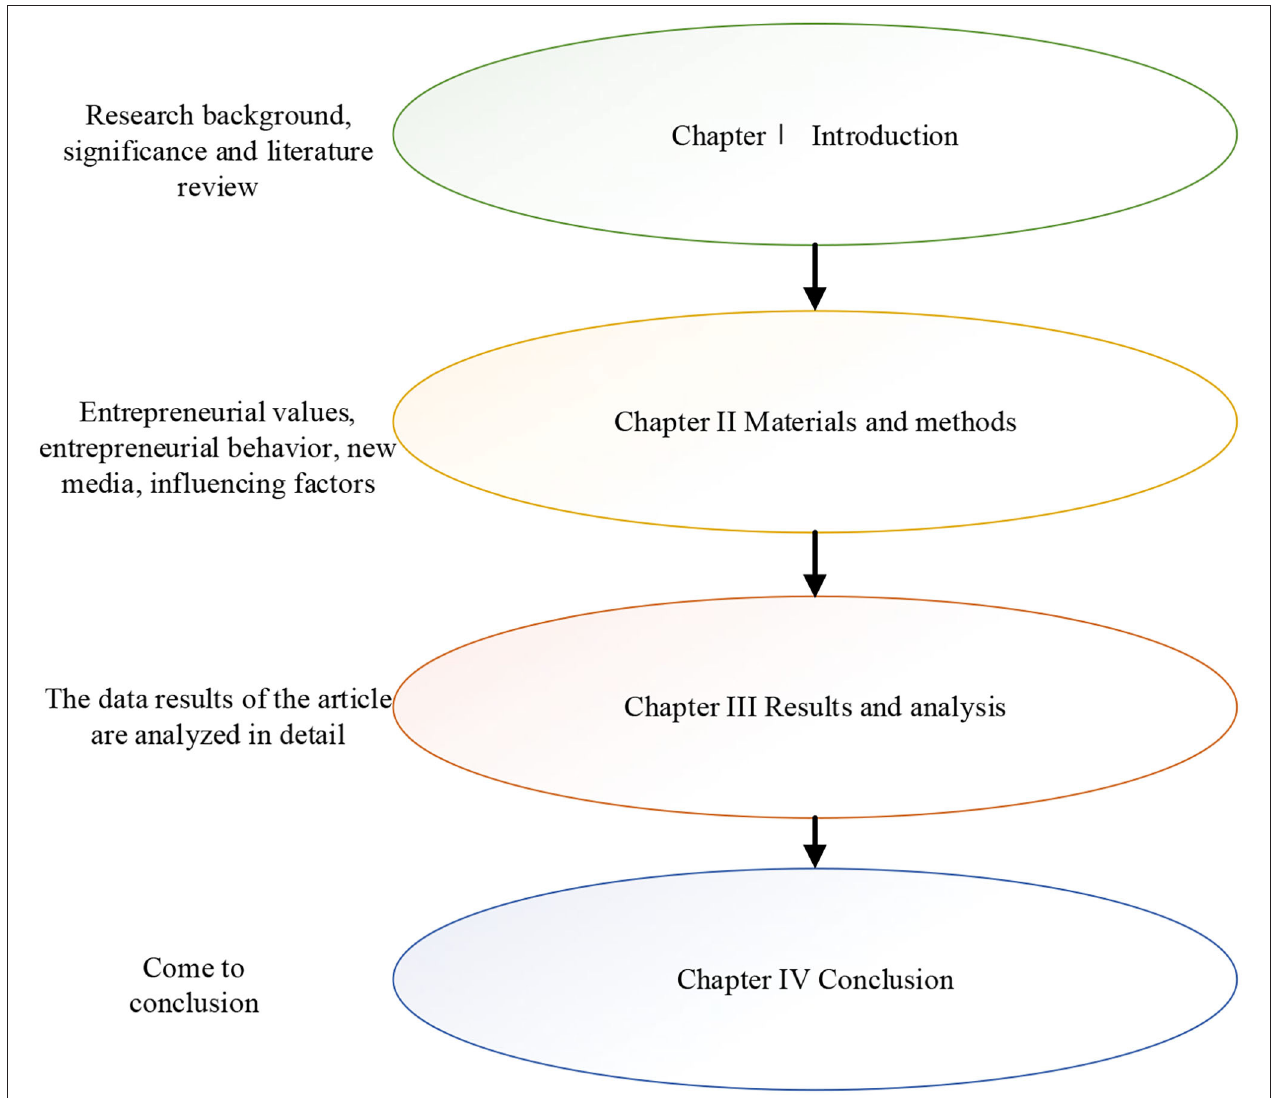
FIGURE 1 | Research